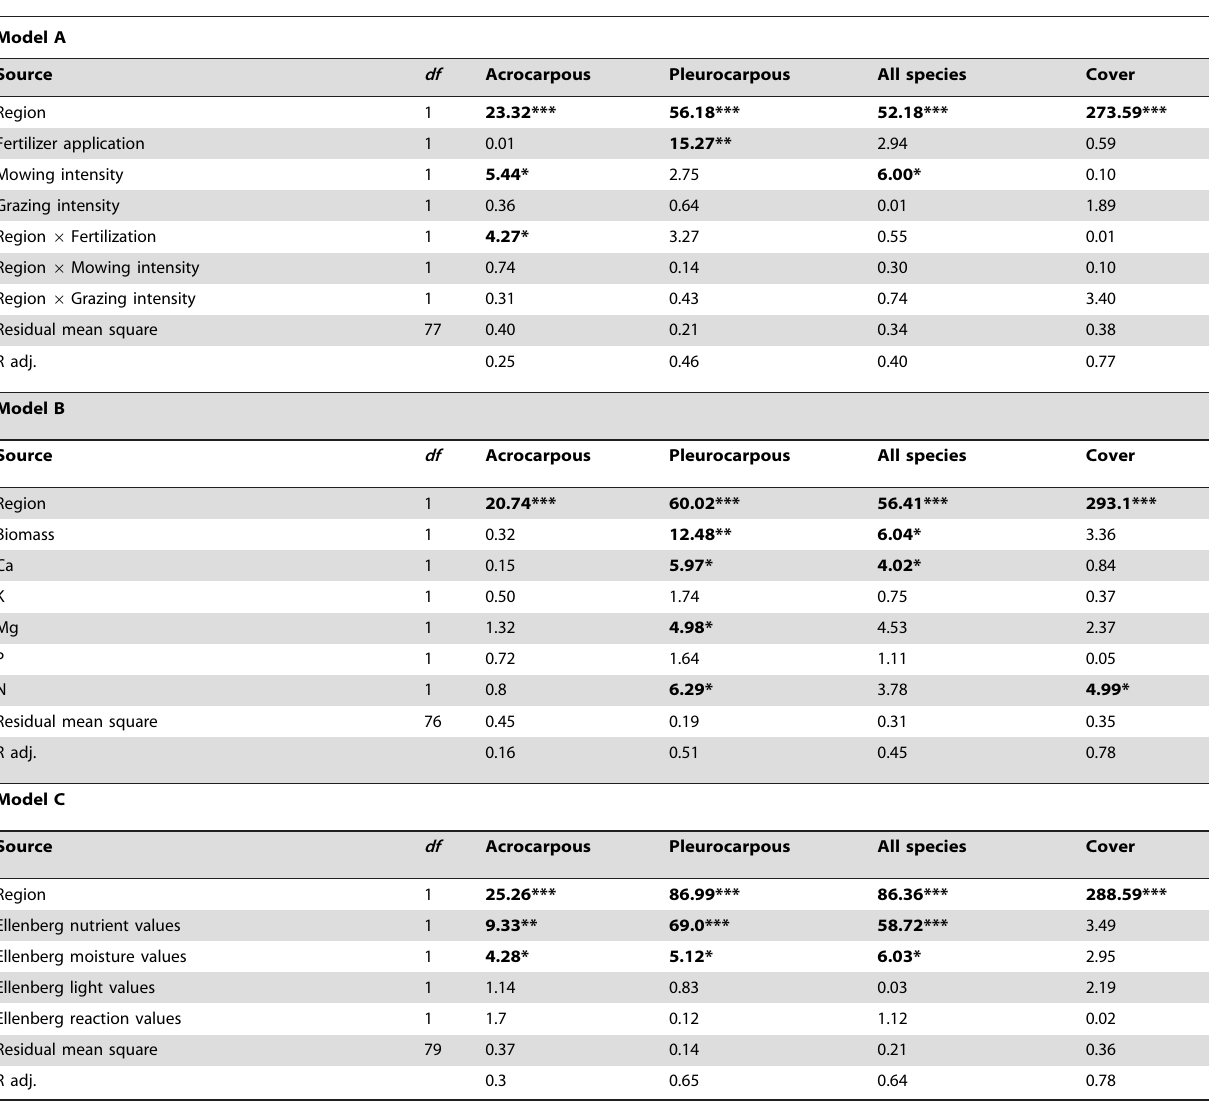
Table 2. Summaries of multiple regression